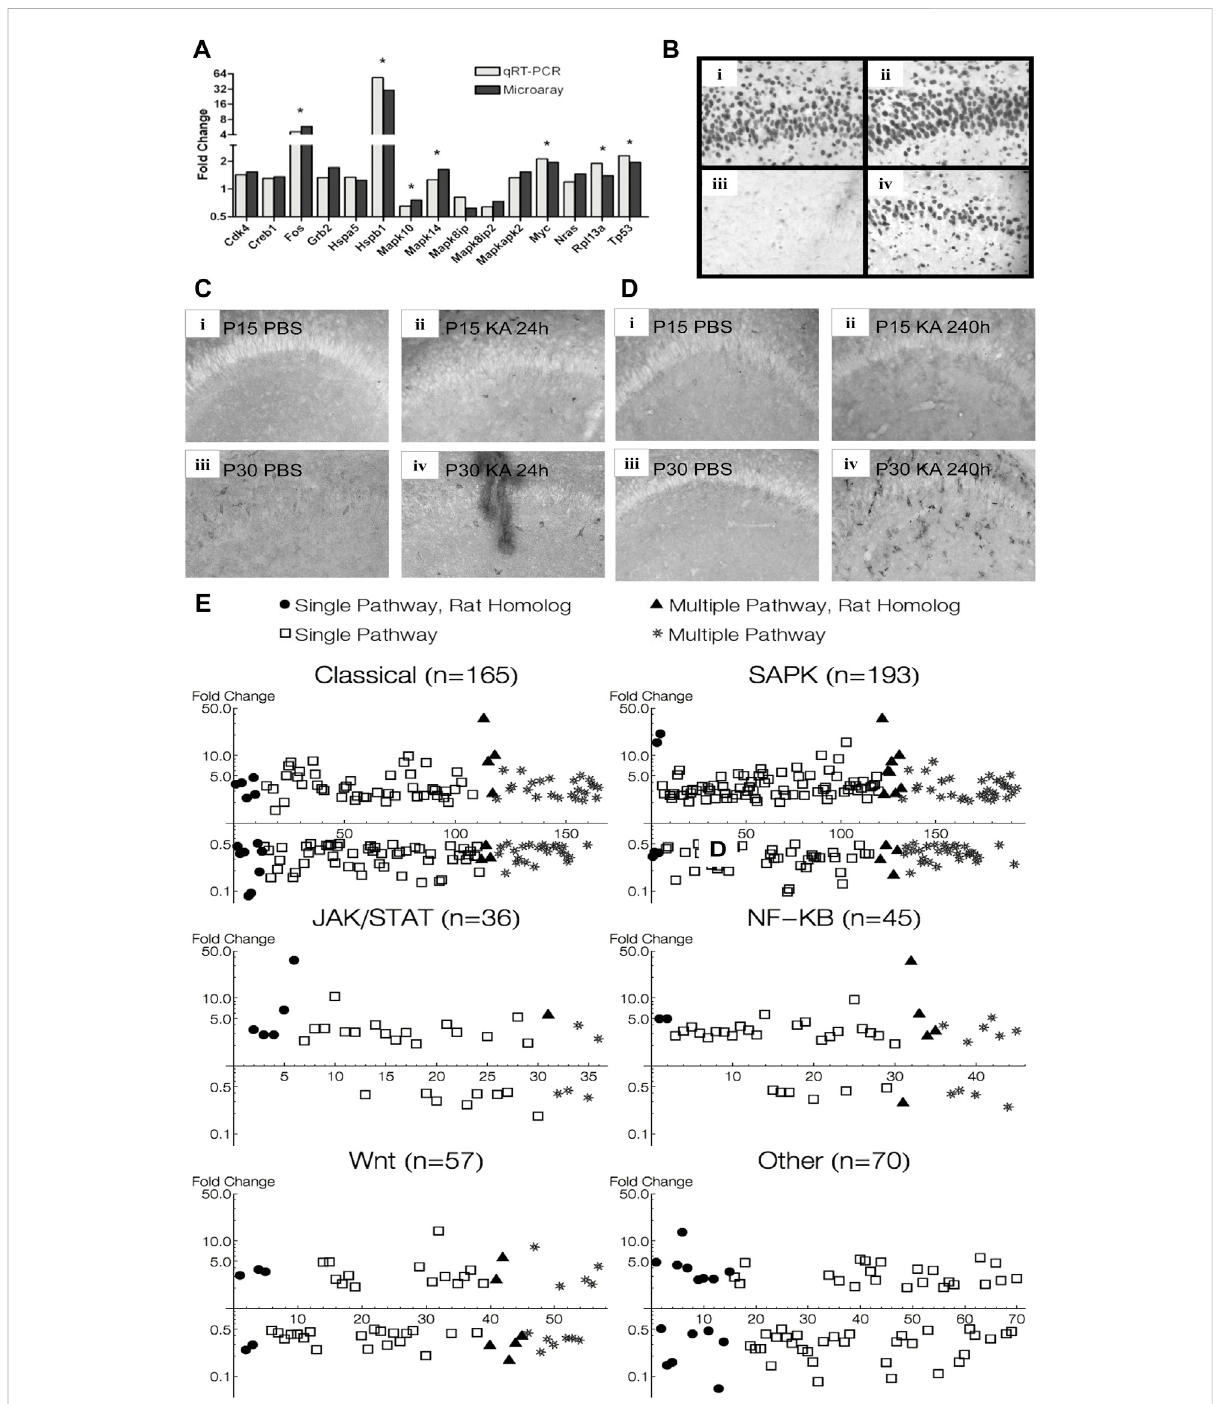
FIGURE 9 Veri fi cation of MAPK pathway genes found in animal experiments. (A) qRT-PCR veri fi cation of microarray data of some differentially expressed MAPK pathway genes 24 h after KA-SE in P30 animals. (B) Hippocampal sections stained for Hsp70. High magni fi cation (×20) view of CA1 sub fi eld 24 h after KA-SE at P15 and P30 [ (i) P15 PBS; (ii) P15 KA; (iii) P30 PBS; (iv) P30 KA]. Notice robust Hsp 70 immunoreactivity in P15, undetectable in control P30, and induction by KA-SE at 24 h in P30. (C) Hippocampal sections stained for CD74 24 h after KA-SE [ (i) P15 PBS; (ii) P15 KA; (iii) P30 PBS; (iv) P30 KA]. (D) Hippocampal sections stained for CD74 240 h after KA-SE [ (i) P15 PBS; (ii) P15 KA; (iii) P30 PBS; (iv) P30 KA]. CD74 immunoreactive cells are most notable in P30 240 h after KA-SE. (E) MAPK pathway genes found in microarray analysis of hippocampus